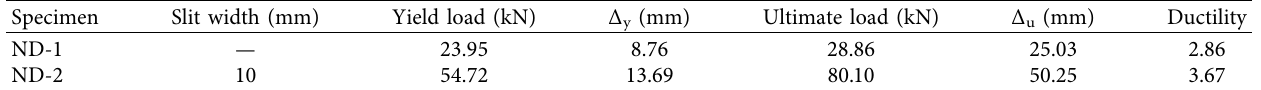
Table 2: Loads, displacement, and ductility.